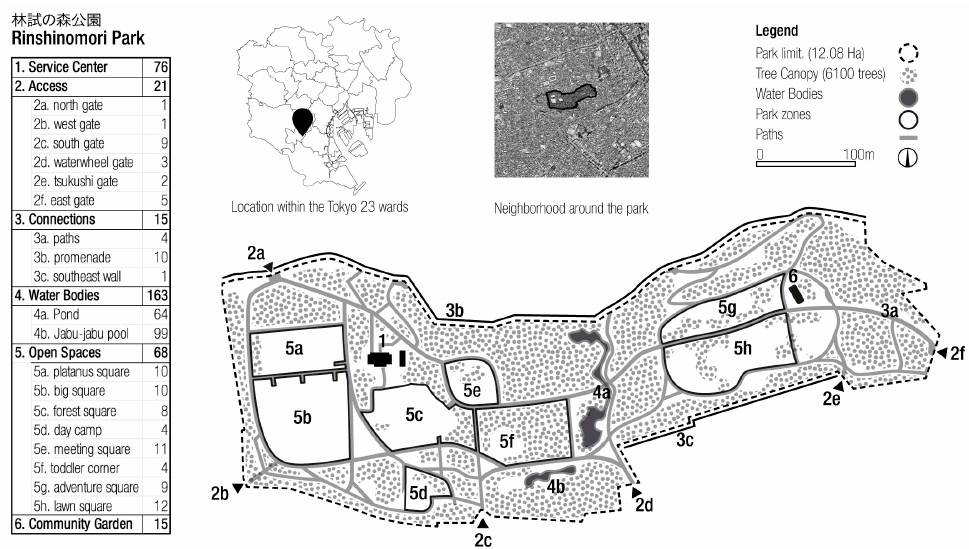
Figure 7. The number of times a speci fi c place inside the park is mentioned in a